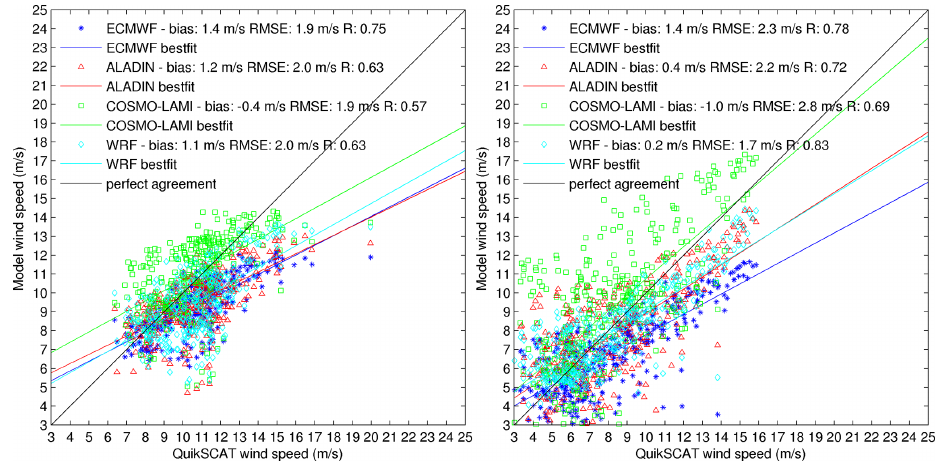
Figure 3. Scatterplot of the wind speed of the QuikSCAT scatterometer and the four NWP models for the satellite passes of 17 November (left) and 18 November (right). The legends report the bias, the RMSE and the correlation coe ffi cient of the models with respect to the scatterometer observations. In black solid the perfect agreement